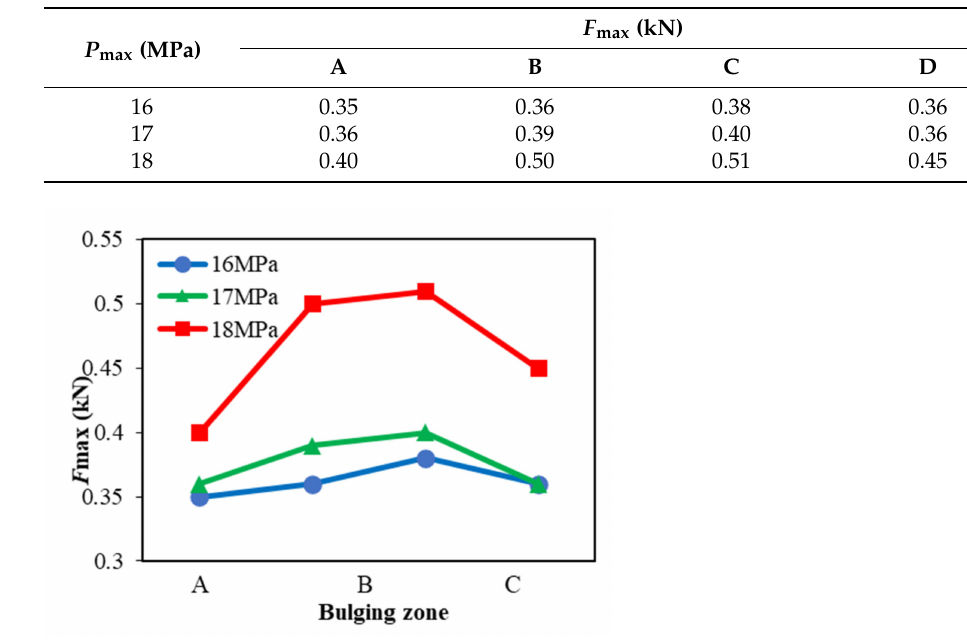
Figure 11. Variation in F max at different bulging zones of tensile test samples and 16, 17, and 18 MPa.